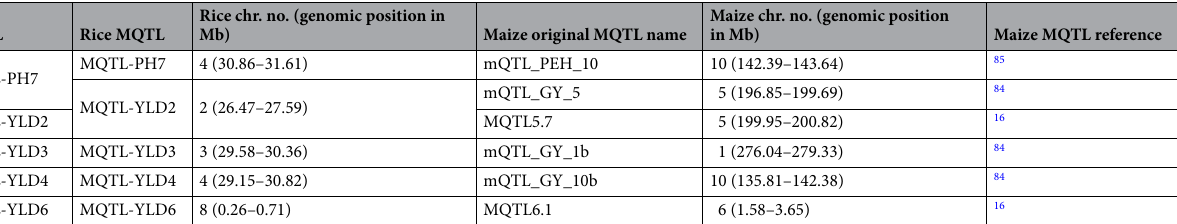
Table 4. Ortho-MQTLs in rice and maize based on the syntenic